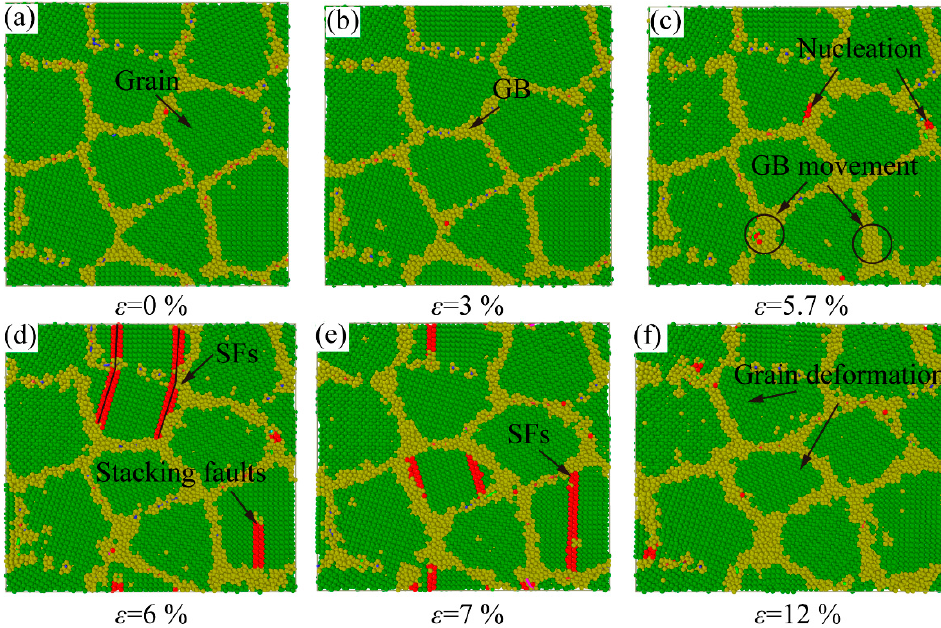
Figure 15. The atomic configurations of polycrystalline Al-2%Mg alloy with grain size D = 5.1 nm at different strains during 300 K tensile simulation. ( a , b ) the elastic deformation stage. ( c − f ) the movement of GB dominates the plastic deformation stage.